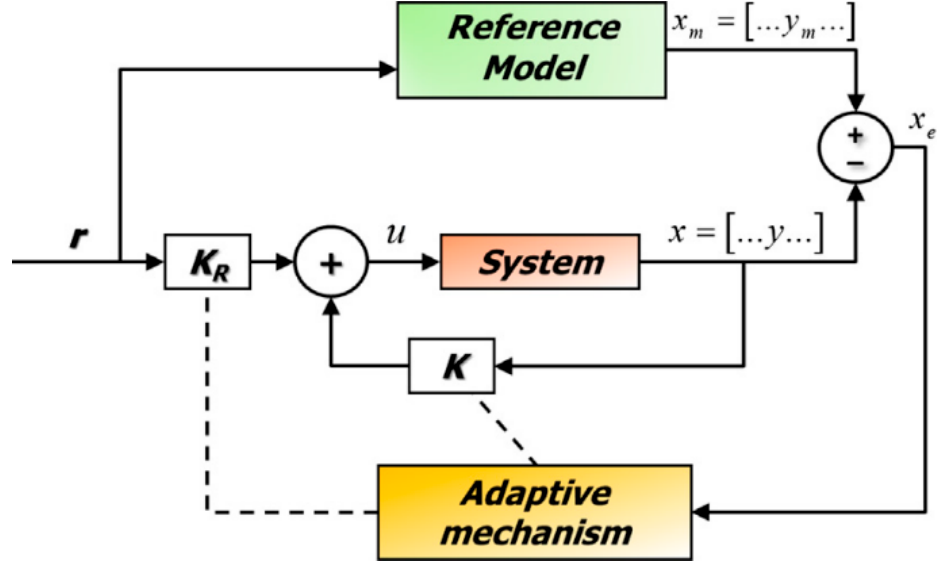
Figure 12. Landau’s Model Reference Adaptive control scheme [139].